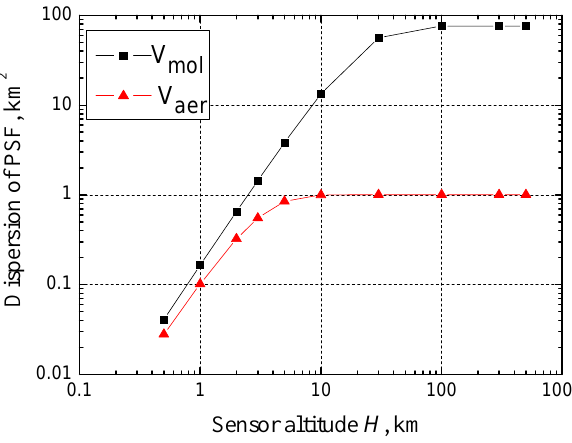
Fig. A1. Dependence of the dispersions V mol (H) and V aer (H) on the sensor